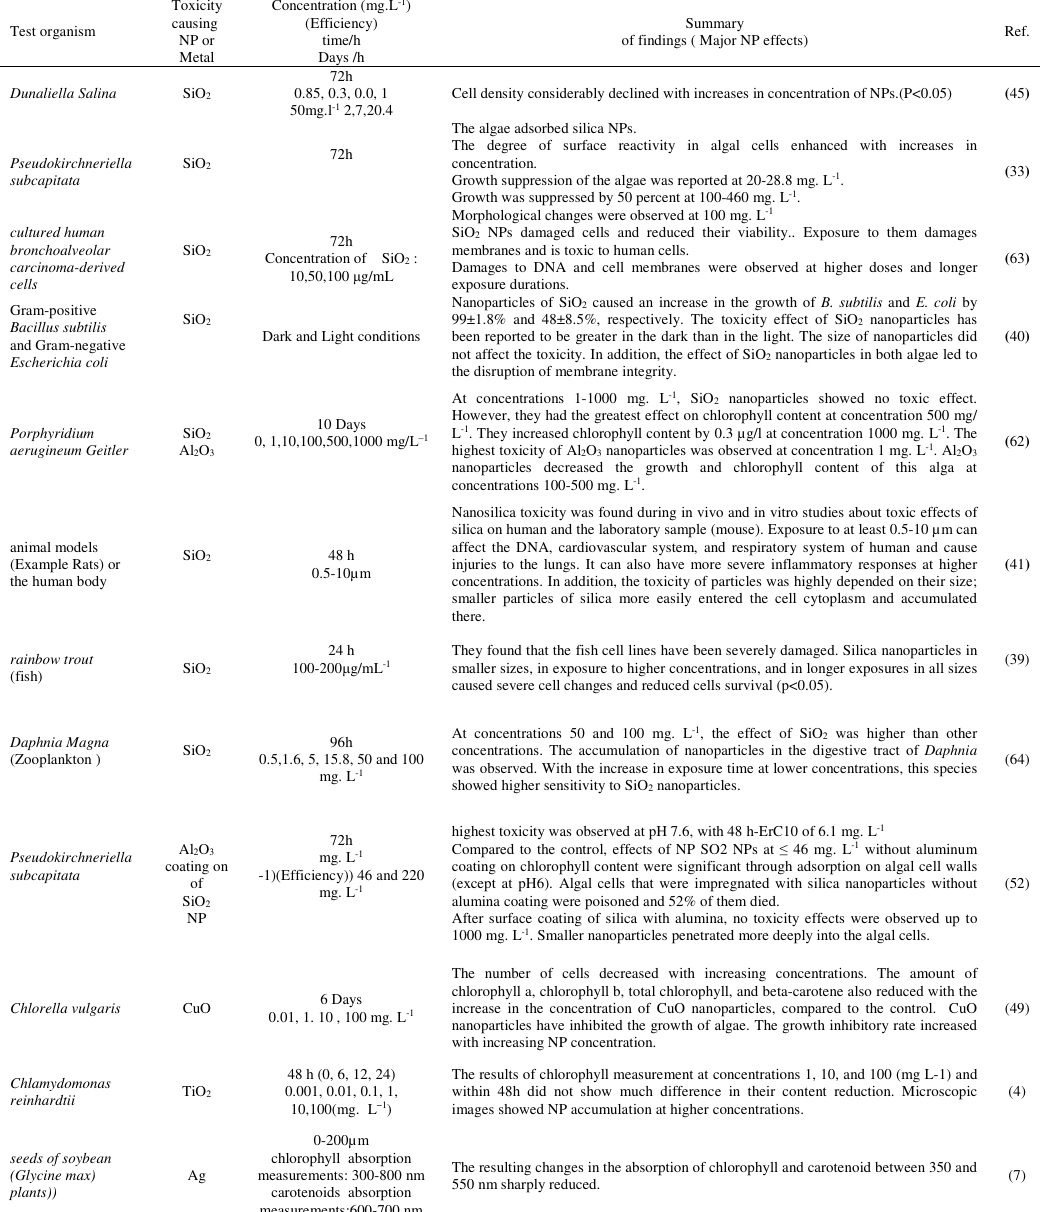
on different organisms different